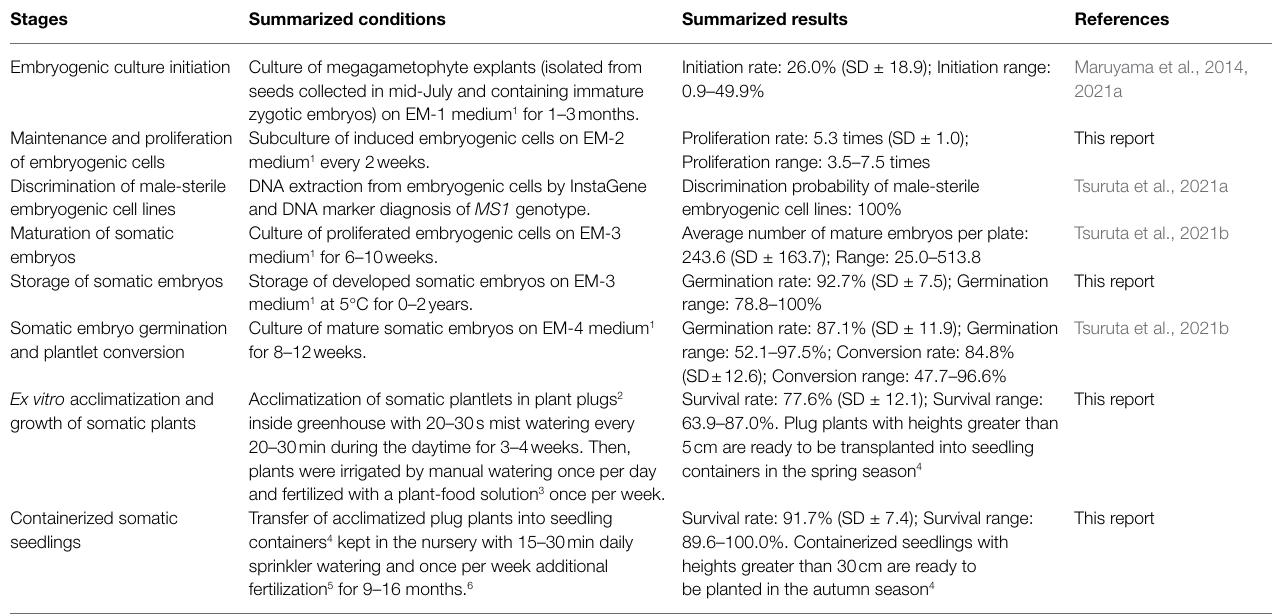
TABLE 5 | Summarized conditions and results for each stage in the propagation of pollen-free sugi ( C. japonica ) plants via somatic